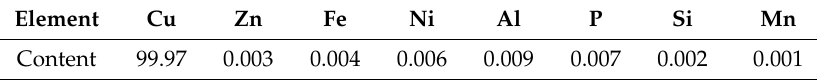
Table 1. Chemical constituents of T2 pure copper (wt%).